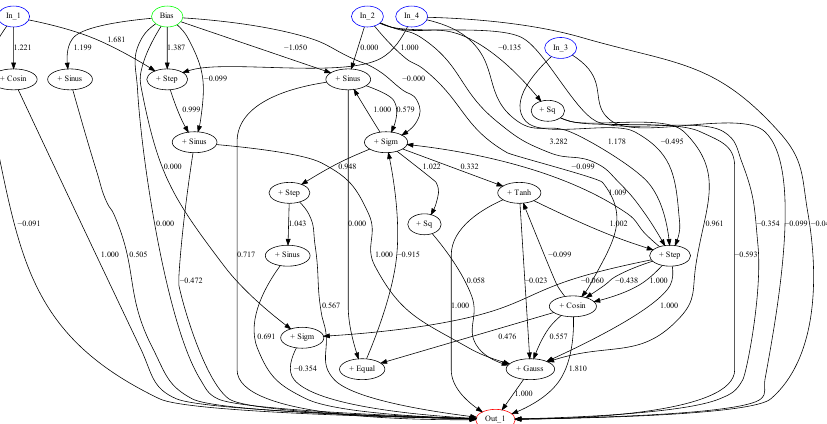
Figure 10. Best controller designed by neuroevolution with